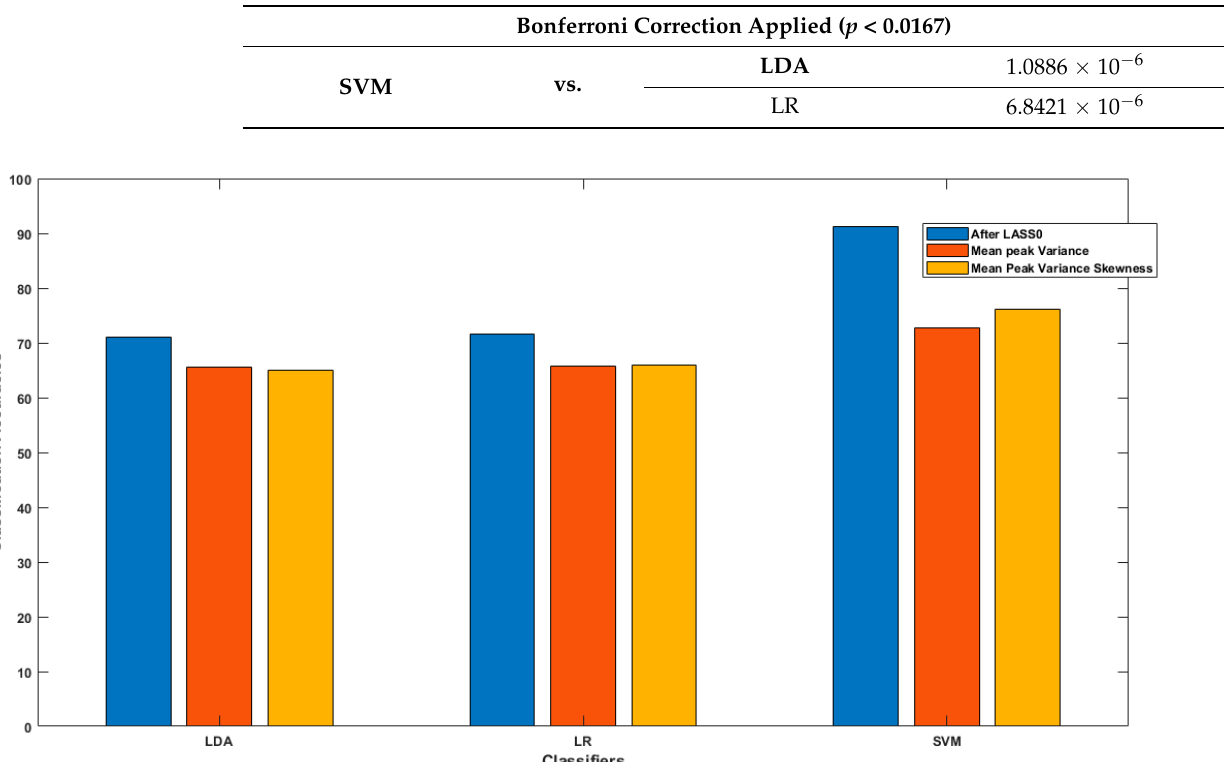
Table 6. Statistical significance of the LASSO homotopy-based sparse representation method.